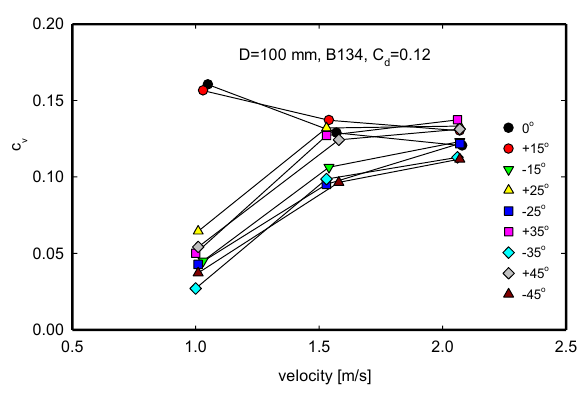
Fig. 2. Effect of the slurry velocity V on manomeric pressure gradient I m ( C d = 0.25).